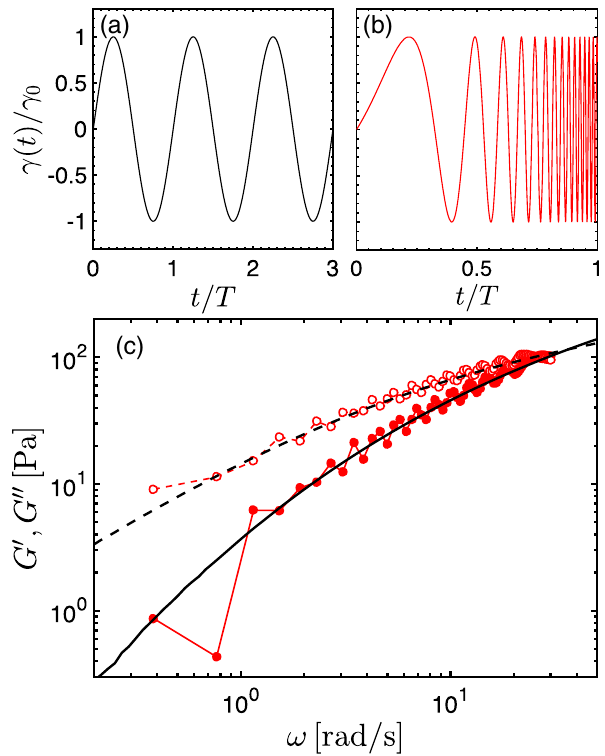
FIG. 1. (a) Example of a single-tone sine input: sinusoidal strain with constant amplitude γ 0 and frequency ω . (b) Example of an exponential sine sweep or chirp: sinusoidal strain with constant amplitudeandmodulatedfrequency[seeEq.(2)].(c)Comparisonof measured viscoelastic moduli for a reference PIB solution (see Appendix A for details) obtained by a classical discrete frequency sweep ( G 0 , solid line; G 00 , dashed line) with 30 points per decade (total experimental acquisition time greater than 30 min) and with the application of only one chirp signal ( G 0 , red solid line and filled circle; G 00 , red dashed line and circle) as described by Eq. (2) with T ¼ 14 s, ω 1 ¼ 0 . 3 rad = s, ω 2 ¼ 30 rad = s, and TB ¼ 66 at the same input strain amplitude γ 0 ¼ 6%